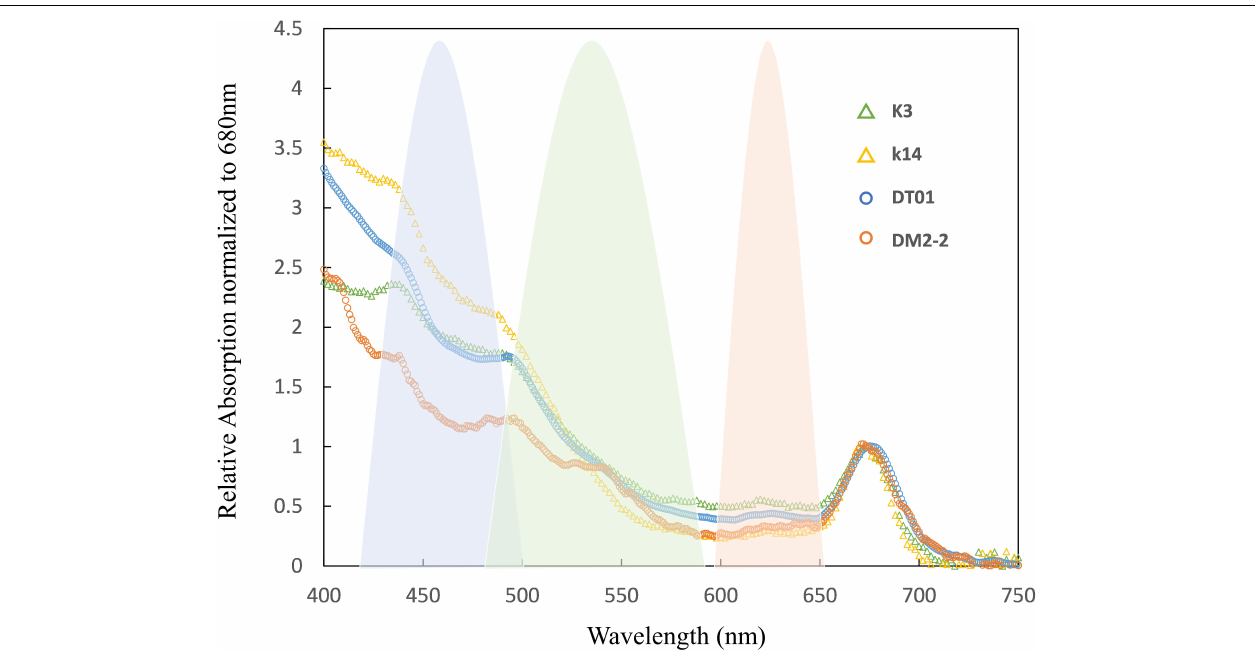
FIGURE 6 | Normalized spectral absorption characteristics of Trichodesmium measured at four sampling stations (K3, K14, DT-01, DM2-2). The blue, green, and orange shades are the excitation spectrum (relative to quanta) of the light source of the FastAct2 (see “Materials and Methods” section).